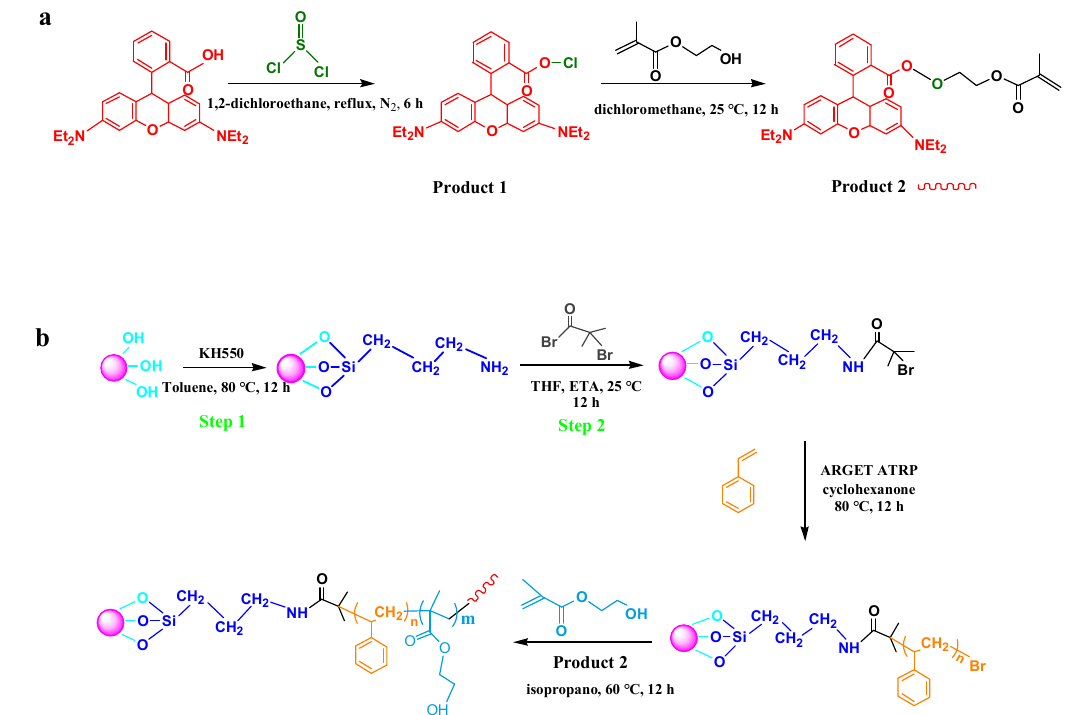
Figure 1. General synthetic procedure to fabricate SNPs- g -PS- b -PHEMA-RhB: ( a ) Synthesis of the HEMA-RhB (Product 2) and ( b ) Synthesis of SNPs- g -PS- b -PHEMA-RhB via surface-initiated.